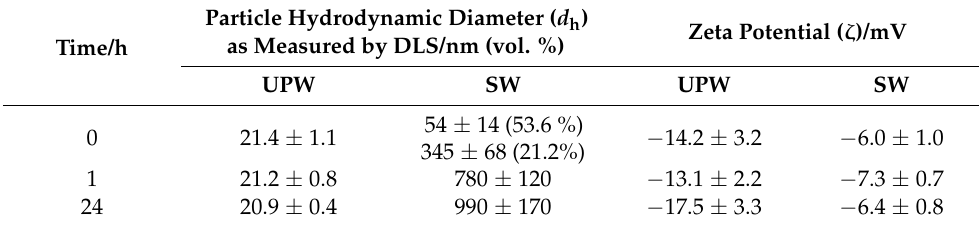
Table 1. Physicochemical characterization of SiO 2 nanoparticles (10 µ g mL − 1 ) in ultrapure water (UPW) and filtered natural seawater (SW) by DLS and ELS. Particle Hydrodynamic Diameter ( d h ) as Measured by DLS/nm (vol. %) Time/h